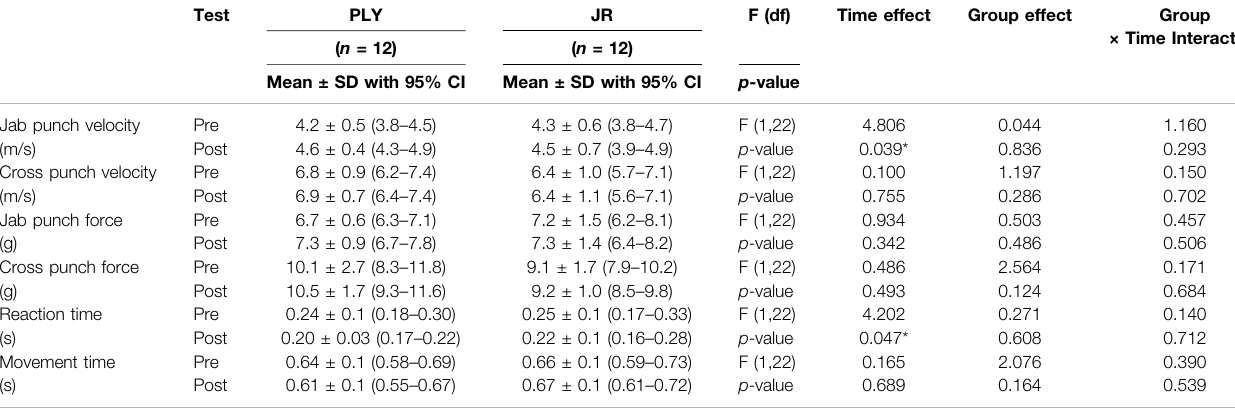
TABLE 4 | Biomechanical characteristics of jab-cross punch before and after PLY or J.R. training. Test PLY JR F (df) Time effect Group effect